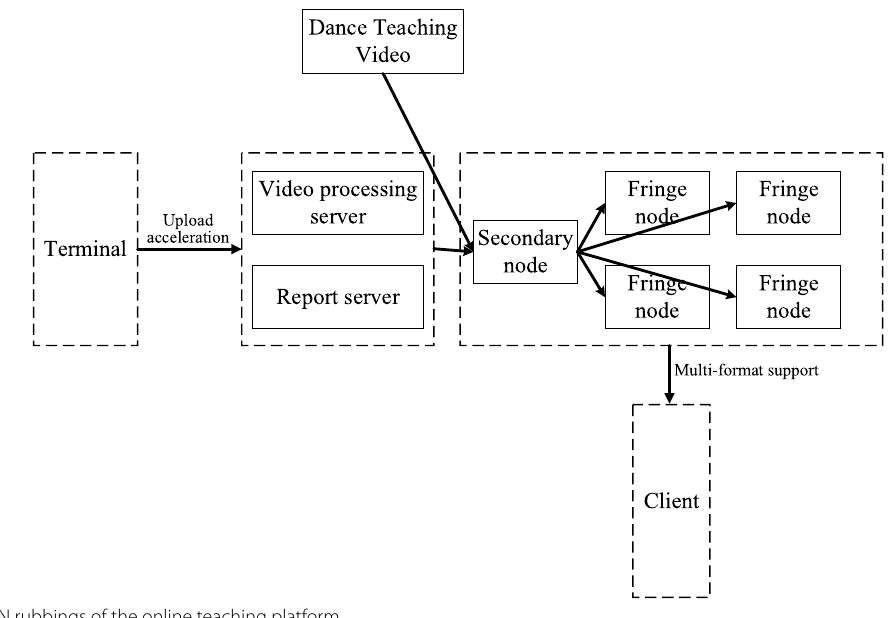
Fig. 16 The CDN rubbings of the online teaching